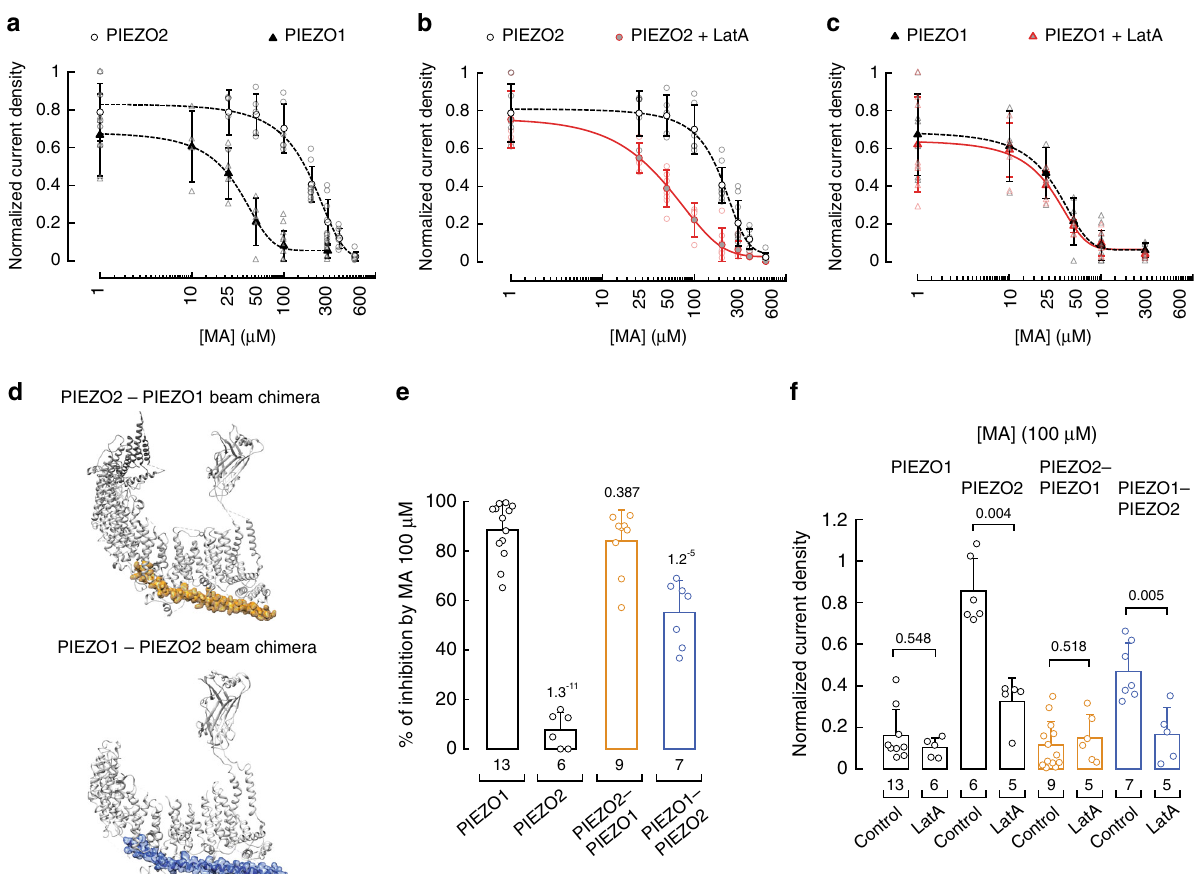
Fig. 2 Latrunculin A enhances PIEZO2 inhibition by MA. a Normalized current density elicited by maximum displacement of MA-supplemented N2A cells (expressing endogenous Piezo1; triangles) and MA-supplemented N2A Piezo1 − / − cells transfected with Piezo2 (circles). A Boltzmann function, Eq. (2), was fi tted to the data. Symbols are mean ± SD. From left to right, n for PIEZO1: 6, 4, 4, 5, 13, and 7 and PIEZO2: 5, 5, 5, 6, 9, 9, 6, and 7. b Normalized current densities elicited by maximum displacement of MA-supplemented N2APiezo1 − / − cells transfected with Piezo2, treated with and without latrunculin A (red and black curves, respectively). A Boltzmann function, Eq. (2), was fi tted to the data. Circles are mean ± SD. From left to right, n for PIEZO2 with latrunculin A: 6, 5, 7, 5, 8, 7, 4, and 5, and PIEZO2: 5, 5, 5, 6, 9, 9, 6, and 7. c Normalized current densities elicited by maximum displacement of MA-supplemented N2A cells (expressing endogenous Piezo1), treated with and without latrunculin A (red and black curves, respectively). A Boltzmann function, Eq. (2), was fi tted to the data. Triangles are mean ± SD. From left to right, n for PIEZO1 with latrunculin A: 8, 5, 6, 6, 6, and 5, and PIEZO1: 6, 4, 4, 5, 13, and 7. d Top, ribbon representation of PIEZO2 monomer (PDB ID: 6KG7; gray) highlighting the residues that were exchanged for those of PIEZO1 (yellow). Bottom, ribbon representation of PIEZO1 monomer (PDB ID: 5Z10; gray) highlighting the residues that were exchanged for those of PIEZO2 (blue). e Inhibition by MA supplementation of N2A cells and N2A Piezo1 − / − cells transfected with Piezo2 , and Piezo2 - Piezo1 and Piezo1 - Piezo2 beam chimeras. Error bars represent SD. n is denoted above the x -axis. Two-tailed unpaired t -test. f Normalized current densities elicited by maximum displacement of MA-supplemented N2A cells (expressing endogenous Piezo1 ) and N2A Piezo1 − / − cells transfected with Piezo2 , and Piezo2 - Piezo1 and Piezo1 - Piezo2 beam chimeras treated with and without latrunculin A. Error bars represent SD. n is denoted above the x -axis. Two-tailed unpaired t -test for PIEZO1 and two-tailed Mann – Whitney test